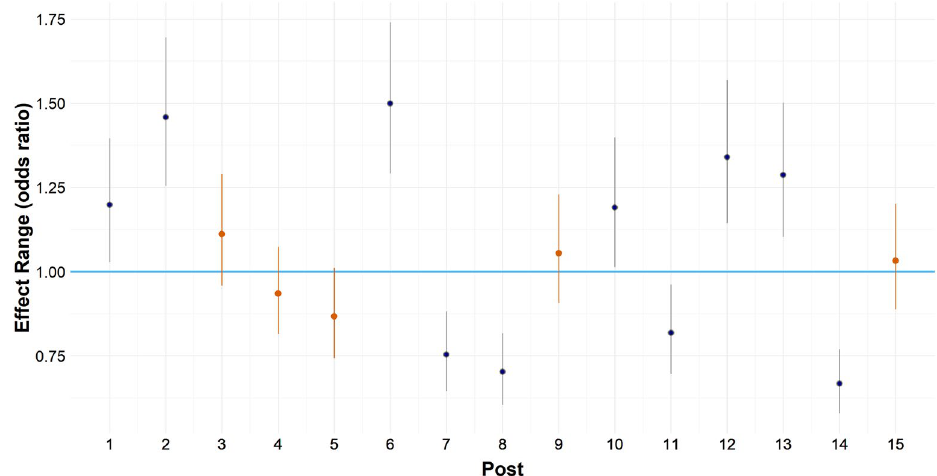
Figure 3. Random differences (Arm 3 | Post), ‘reactions’. Posts varied in their deviations from the global average effect of the inoculation intervention, with some posts having higher odds of being ‘reacted’ to than the average, and other posts having lower odds of being ‘reacted’ to than the average. Posts 1–5 comprised misinformation relating to health; posts 6–10 comprised misinformation relating to politics; and posts 11–15 comprised misinformation relating to